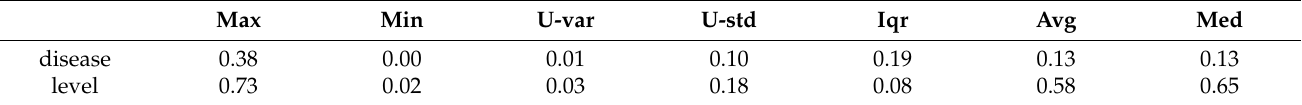
Table 3. Rank correlation coefficient between each feature value and target